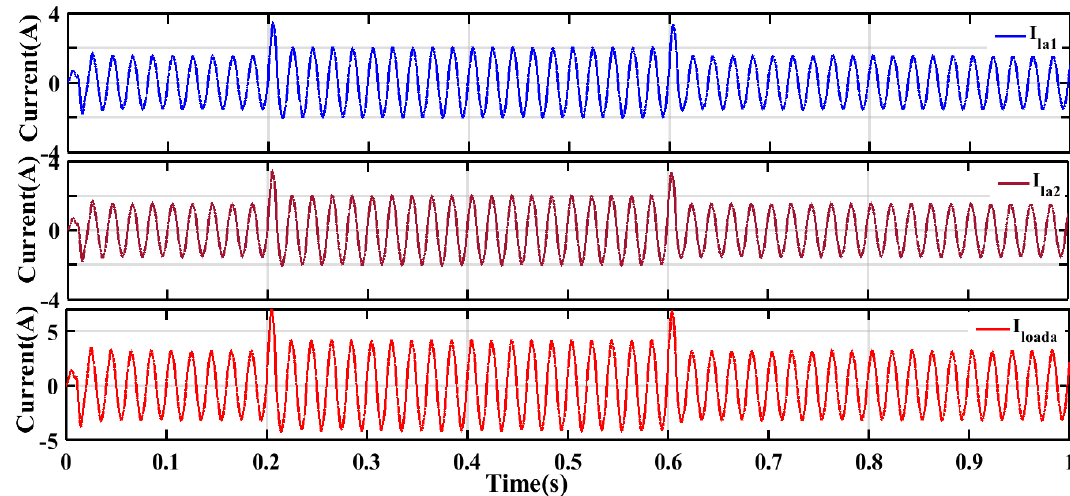
Figure 12. Parallel operation for transient load condition.